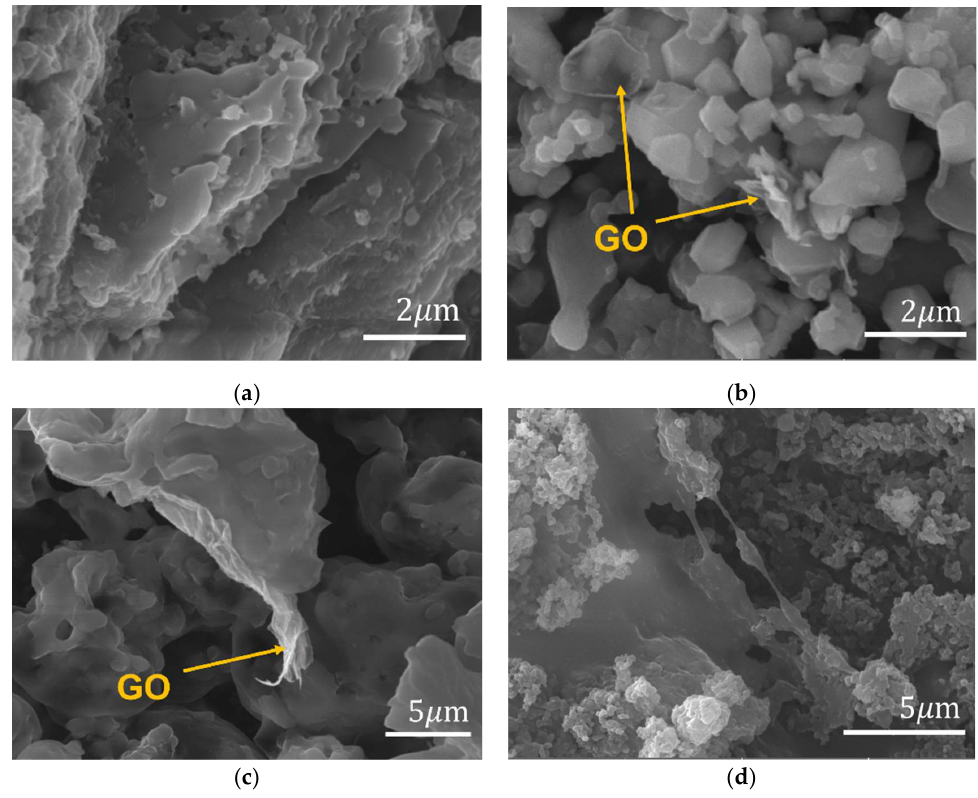
Figure 3. SEM micrographs of ( a ) ZnAl 2 O 4 : Mn annealed at 1400 ℃ ; ( b ) ZnAl 2 O 4 : Mn/GO; ( c ) ZnAl 2 O 4 : Mn/GO-Br; ( d ) ZnAl 2 O 4 : Mn/GO-PMMA at 10kx magnification. ( c ) ZnAl 2 O 4 : Mn/GO-Br; ( d ) ZnAl 2 O 4 : Mn/GO-PMMA at 10kx